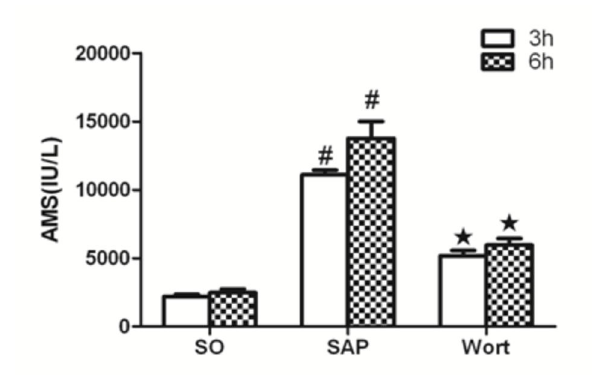
Figure 1. Histological examination of pancreas in each group at the 3 h and 6 h time point (original magnification, 400x). A: SO group, observed at 3 h time point; B: SAP group, observed at 3 h time point; C: W group, observed at 3 h time point; D: SO group, observed at 6 h time point; E: SAP group, observed at 6 h time point; F: W group, observed at 6 h time point.